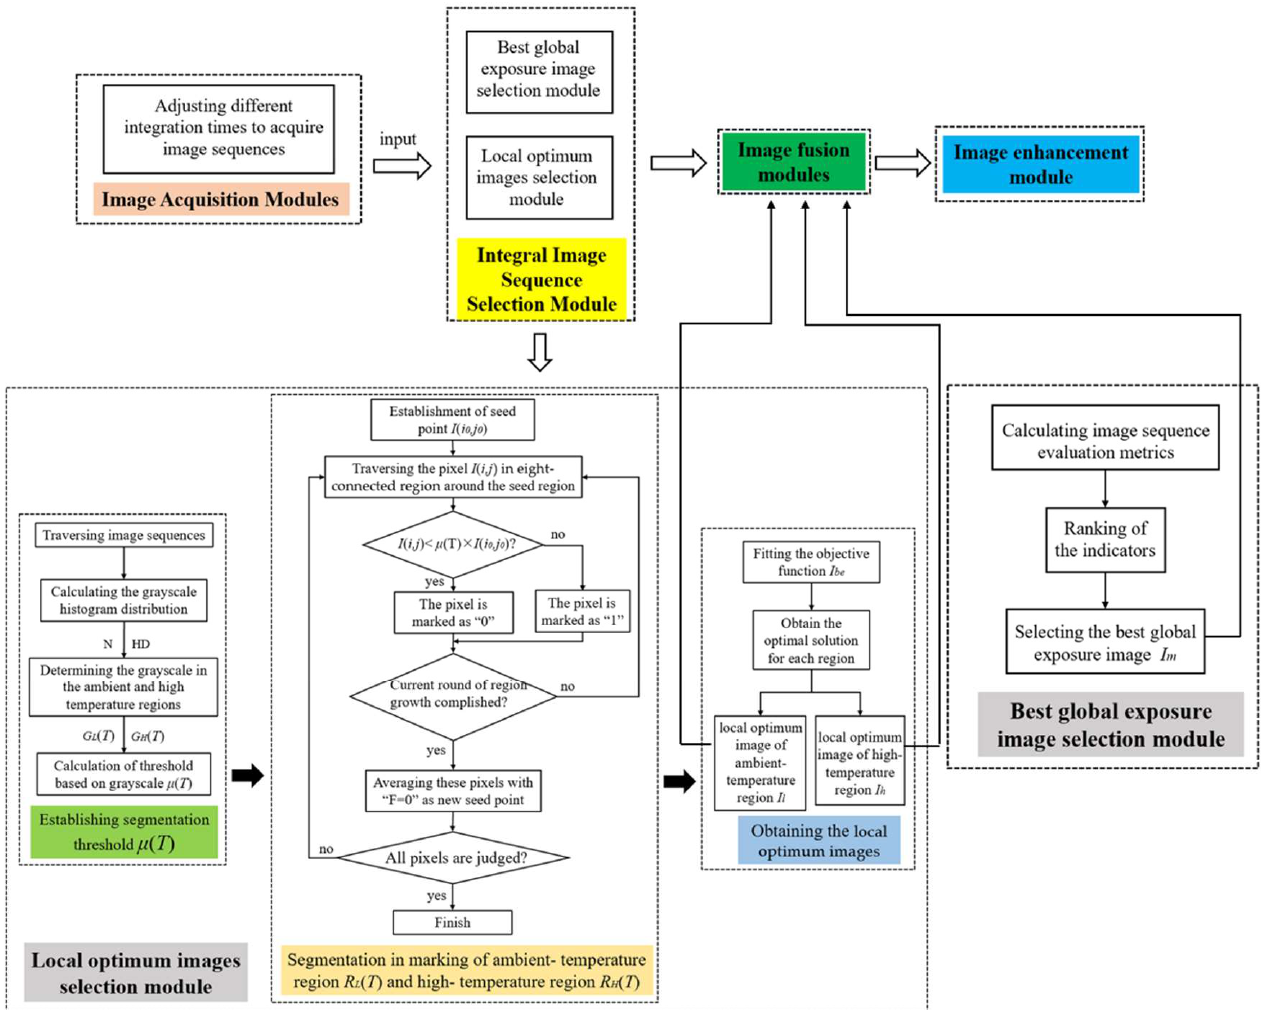
Figure 10. Flowchart of multi-integration time adaptive selection method for superframe high- dynamic-range infrared imaging based on grayscale